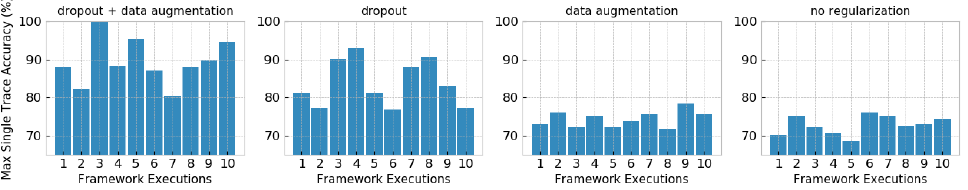
Figure 17: Fixed CNN hyperparameters: maximum single trace accuracy on the cswap- arith dataset for ten different framework